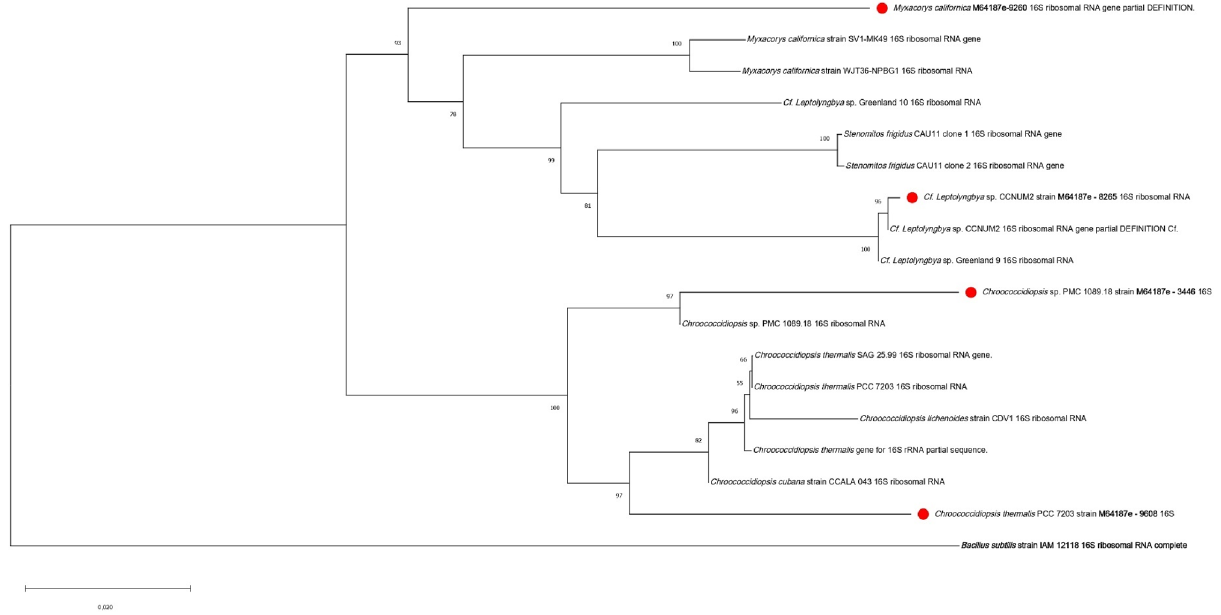
Figure 5. Topology of the 16S rRNA gene sequences of the cyanobacterial strains isolated from the present study and their closely related sequences from the NCBI database constructed using the neighbor-joining method 46 . The percentage of replicate trees in which the associated taxa clustered together in the bootstrap test (1000 replicates) are shown next to the branches 47 . Five base substitutions for nucleotide positions are represented by the scale bar. The sequences obtained in the present study are indicated by red